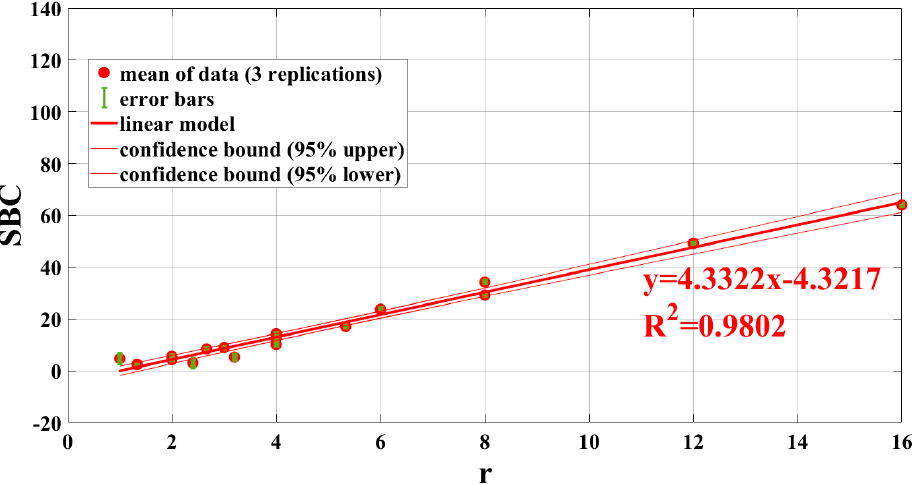
Figure 19. SBC versus r for slope 1024 frames, error bands and confidence bounds on the find linear model.